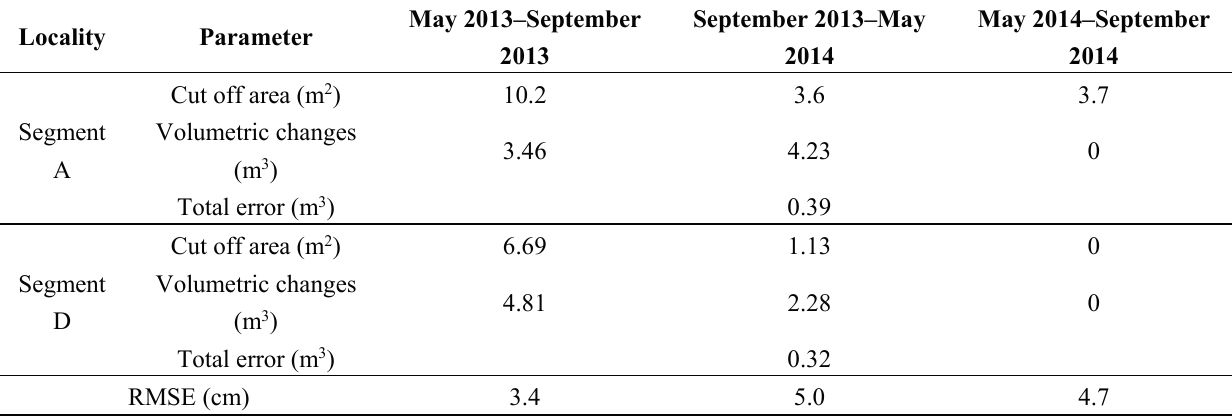
Table 5. Progress of bank erosion between 2013 and 2014 in the selected